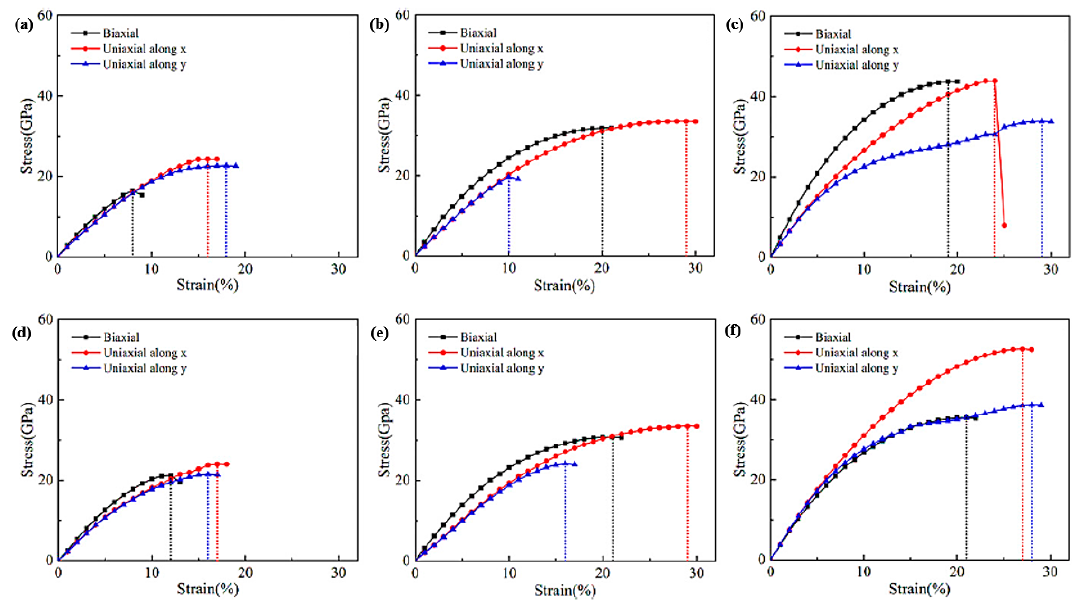
Figure 2. Strain-stress relationships for ( a ) Ti 2 C, ( b ) Ti 2 CF 2 , ( c ) Ti 2 CO 2 , ( d ) Zr 2 C, ( e ) Zr 2 CF 2 , and ( f ) Zr 2 CO 2 under both biaxial and uniaxial load conditions. Reproduced with permission from [ 30 ] . Copyright PNAS, 2017.